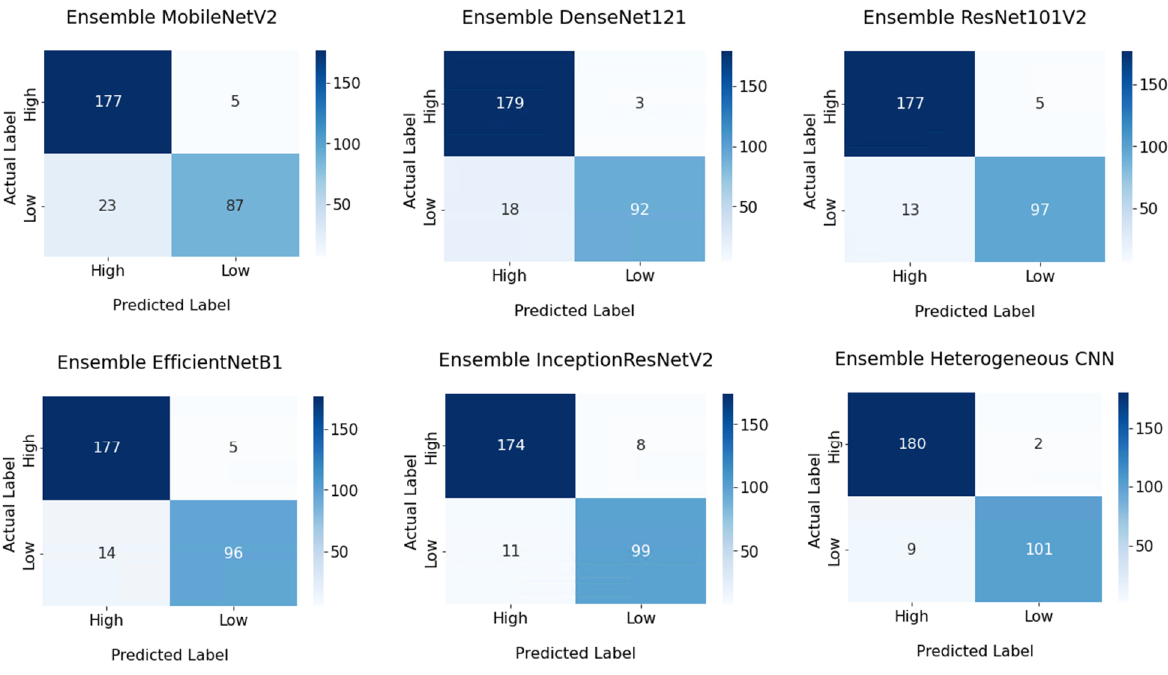
Figure 9. Confusion matrices of 2 classes.